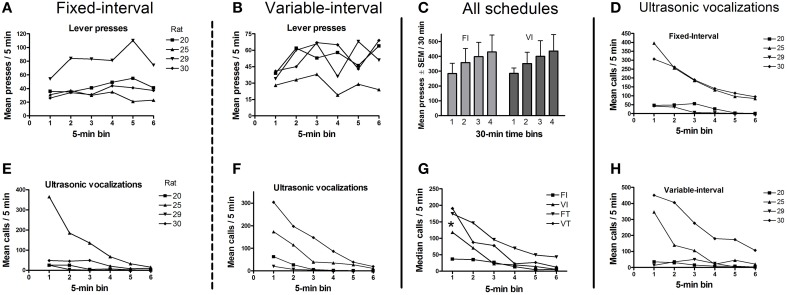
Mean lever presses and mean calls for each schedule (n = 4 rats). (A,B) show that lever press rates under both schedules remained stable across successive 5-min time bins within the first 30 min of the session. (C) shows that response rates tended to increase across the 2-h session. (D–F,H) show mean calls across all four reinforcement schedules, decreasing over the first 30 min of the for each rat. (G) shows that the median call rate decreased over the first 30 min for all schedules, with rats pooled. There was also a significant increase in call number when the optogenetic stimulation was non-contingent (VT and FT schedules) vs. contingent on a lever-press (FI and VI schedules). FI, fixed interval; VI, variable interval; FT, fixed interval; VT, variable interval. All schedules are 20 s. Sign-test *p < 0.02 (n = 8 i.e., 4 rats × 2 schedules).